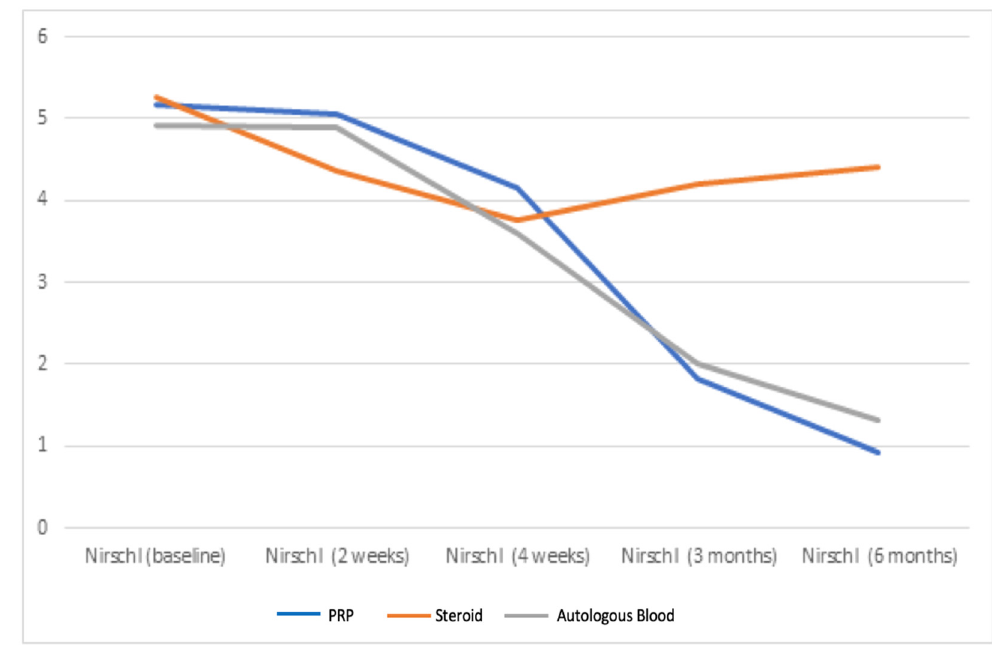
Figure 3. Mean unit improvement in Nirschl score.